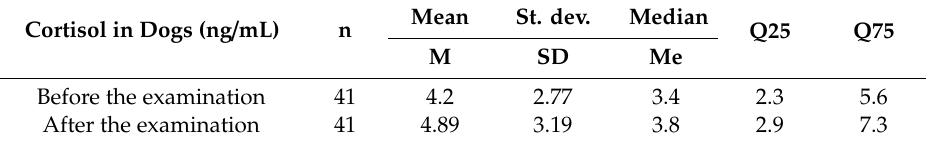
Table2. Table 2. Basic descriptive statistics for salivary cortisol levels in the dogs before and after the examination.